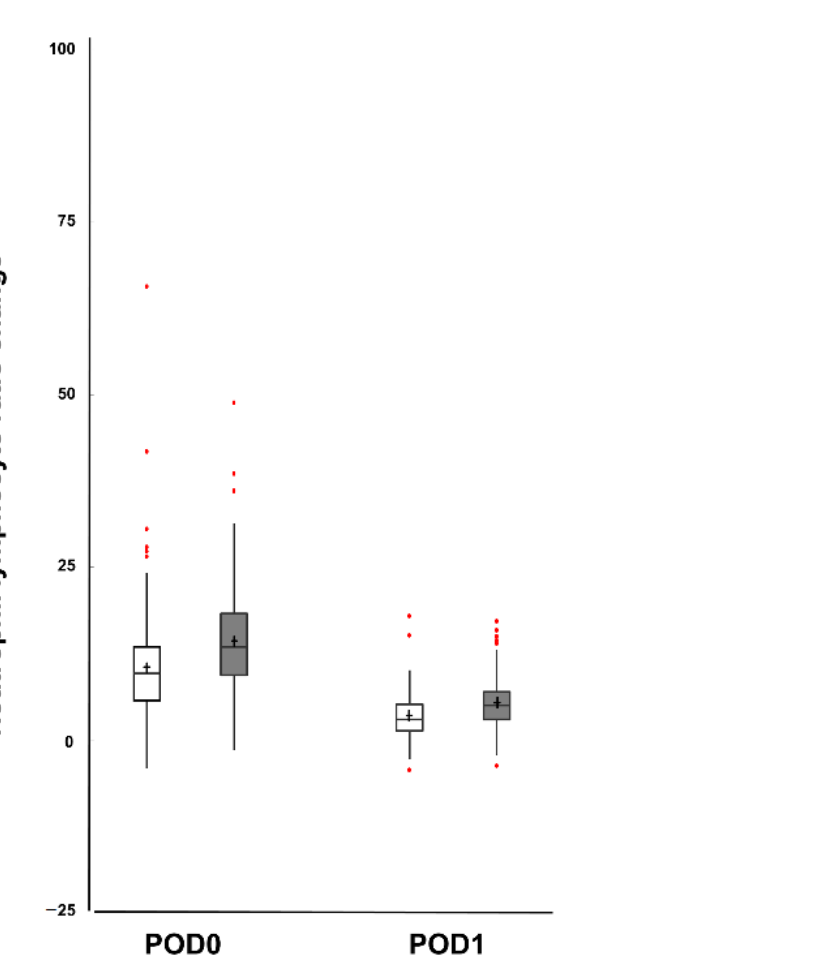
Figure 2. Comparison of the postoperative neutrophil to lymphocyte ratio (NLR) changes on post- operative days (POD) 0 and 1 between the laparoscopic radical hysterectomy group (LRH; white column) and open radical hysterectomy group (ORH; grey column). There were significant dif- ferences in the NLR changes between the two groups ( p < 0.001 for all outcome variables). The central box represents the values from the lower to the upper quartile (25th to 75th percentile). The middle line represents the median. A line extends from the minimum to maximum value, excluding outliers. The cross sign and error bars of each group represent the means and standard deviations, respectively.